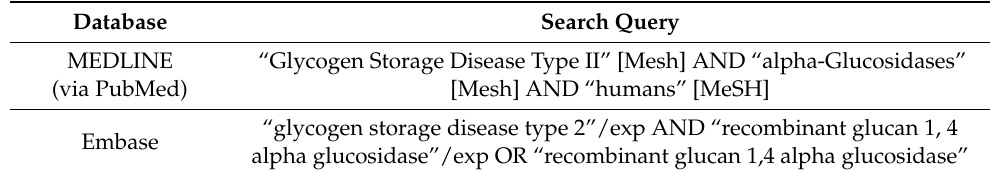
Table 1. Database search